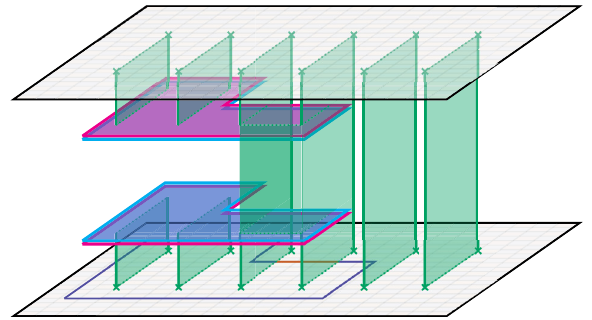
FIG. 30. Since a general Pauli measurement involves an even number of twists, we can always find a valid configuration of domain walls. As shown, we can pair twists and configure domain walls such that their boundary is the desired twists. This portal configuration is to measure the traceable operator depicted at the bottom.